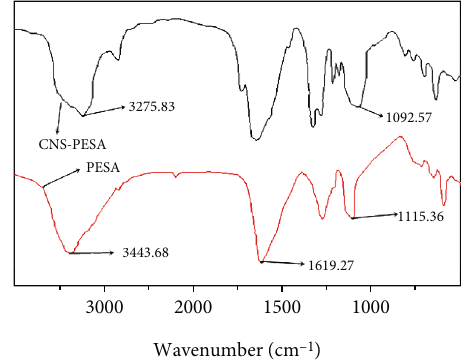
Figure 3: Infrared spectra of CNS-PESA and PESA.